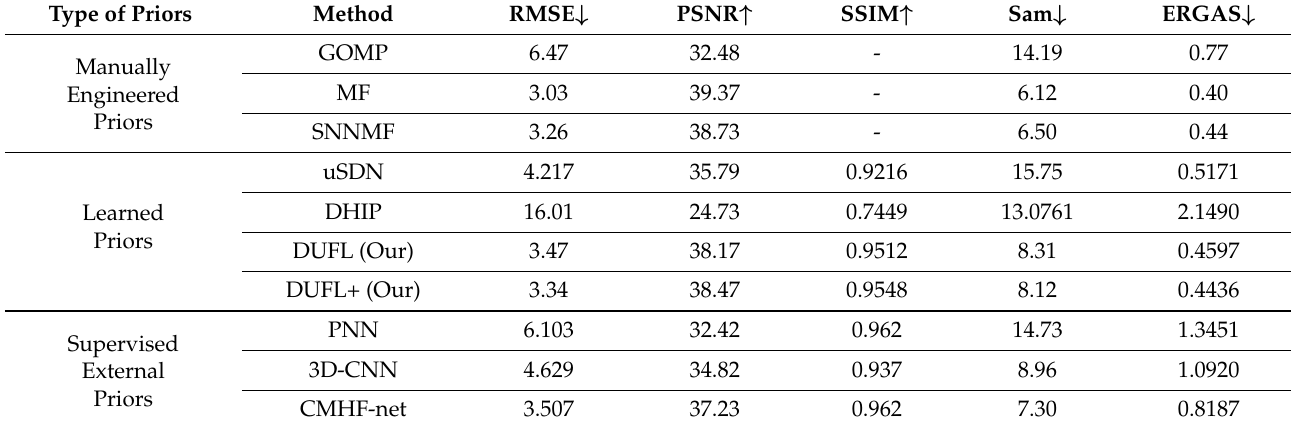
Table 1. Comparison of the quantitative evaluation results obtained using the proposed method with those obtained by state-of-the-art methods, including traditional methods with manually engineered image priors (GOMP [50], MF [16], and SNNMF [51]), unsupervised methods with learned image priors (DHIP [24] and uSDN [41]), and fully supervised deep-learning methods (PNN [52], 3D-CNN [53], and CMHF-net [54]).